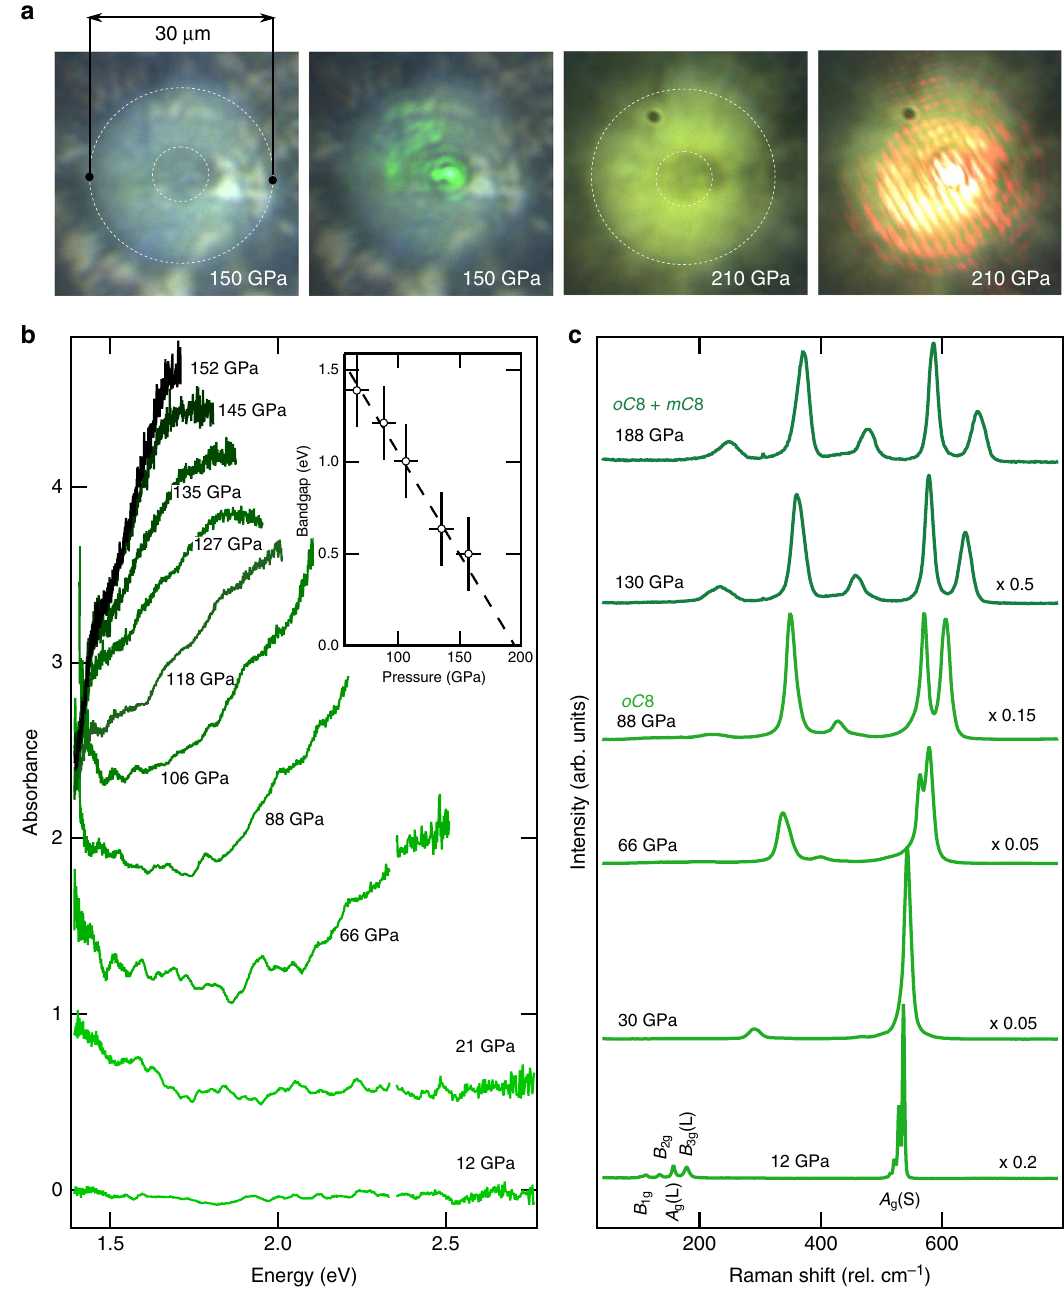
Fig. 1 Optical absorption and Raman measurements up to 200 GPa. a Micrographs of chlorine demonstrating strong re fl ectance of 532 nm and 660 nm light at 150 and 210 GPa, respectively. b Representative absorption spectra for different pressures up to 135 GPa. Linear extrapolations of the absorption provide a tentative band gap value 52 . Inset — band gap measurements, deduced from the host fi gure, as a function of pressure, the extrapolation (solid black line) indicates band gap closure will occur in phases oC 8/ mC 8 at ~200 GPa. Error bars are ±0.2 eV and ±10 GPa. c Raman spectra below 200 GPa illustrating a signi fi cant redistribution of Raman intensities between internal ( A g (S) and B 3g (S)) and external modes ( A g (L) and B 3g (L). The coexistance of phases oC 8 and mC 8, denoted by the dark green colour, is marked by the asymetric pro fi le of the modes coinciding with the emergence of the lowest frequency B 1g (L)-2 mode, see Fig.